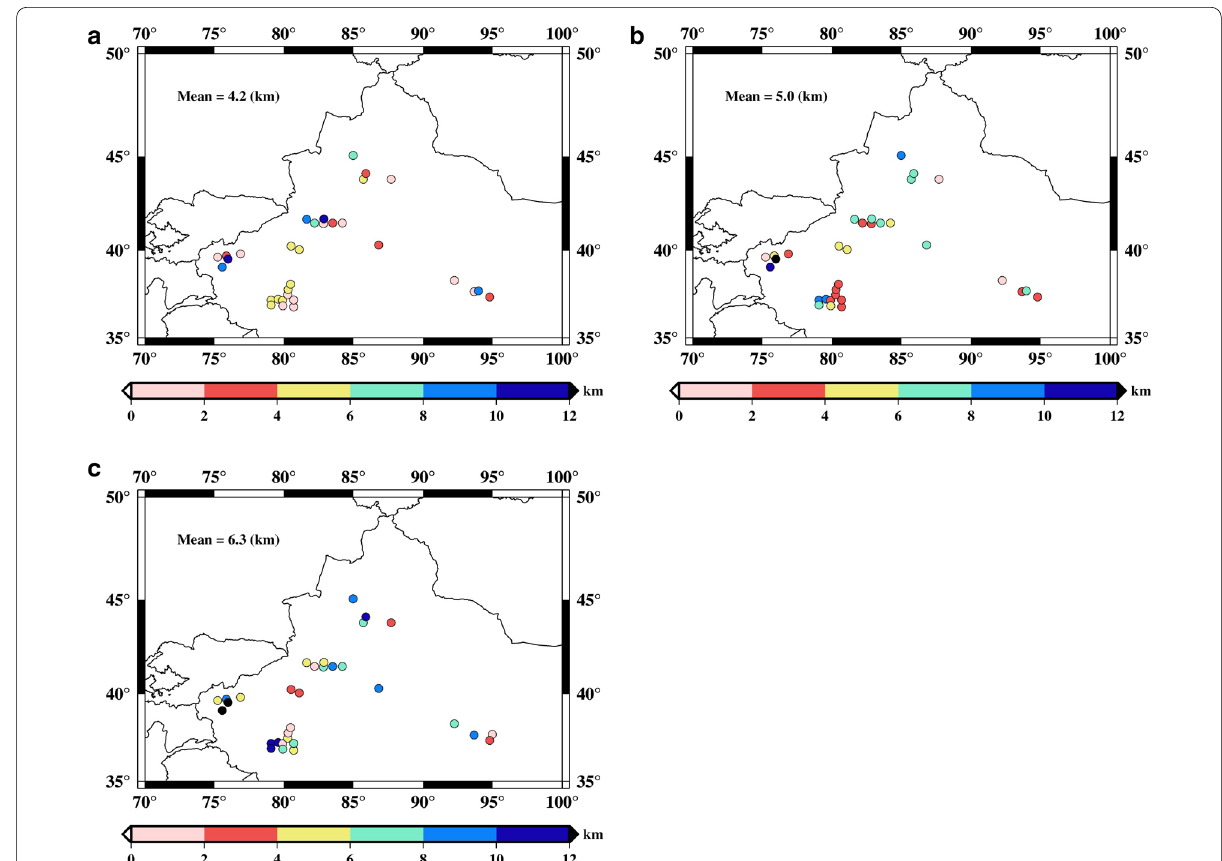
Fig. 8 Absolute differences of Moho depth beneath seismic stations and those from the new maps: a using elevation-corrected sediment after removing short wavelengths (100 km), b using elevation after removing short wavelength (100 km), and c Moho depth from Robert et al.